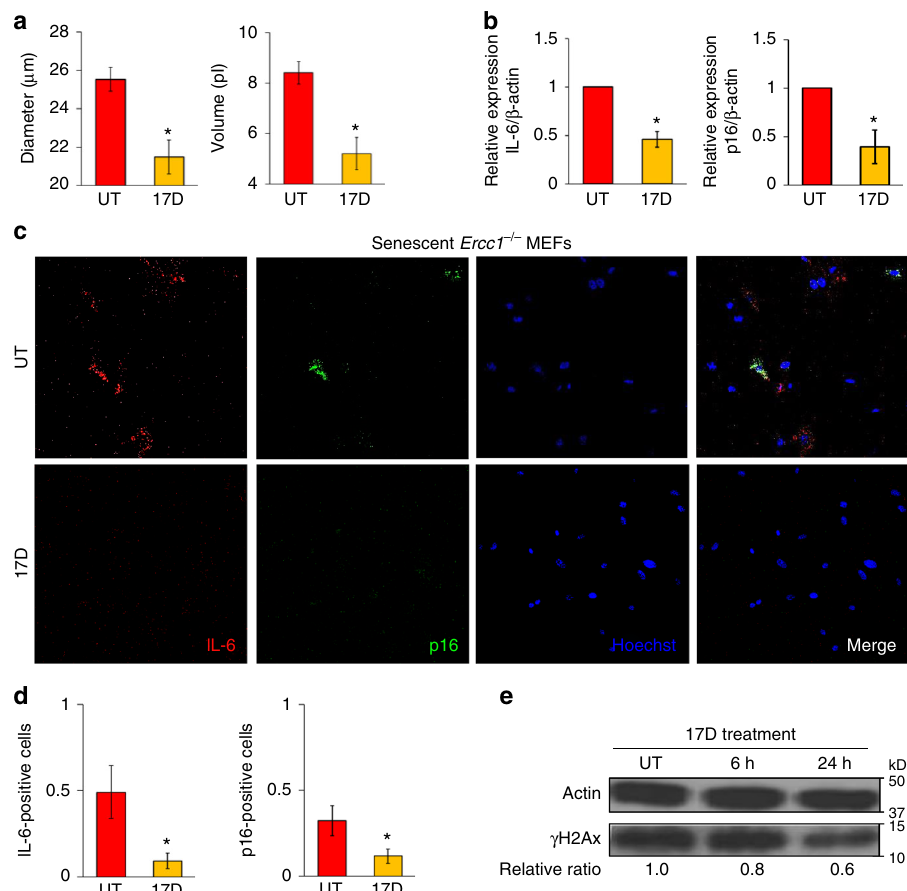
Fig. 7 Multiple senescence markers are reduced in Ercc1 − / − MEFs after treatment with HSP90 inhibitors. a Diameter and volume of senescent Ercc1 − / − MEF cells were measured before ( red ) and after ( orange ) 1 µ M 17-DMAG (17D) treatment for 24 h. Error bars indicate SD for n = 3, * p < 0.05, two-tailed Student ’ s t -test. b Relative mRNA expression of IL-6 and p16 INK4a determined by qRT-PCR was measured in untreated (UT) and 17-DMAG (17D) treated cells for 24 h. Error bars indicate SD for n = 3. * p < 0.05, two-tailed Student ’ s t -test. c Representative FISH images of p16 INK4a ( green ) and IL-6 ( red ) in senescent Ercc1 − / − MEFs with (17D) and without (UT) 17-DMAG treatment. d Quanti fi cation of the fraction of cells expressing p16 INK4a and IL-6 in p5 Ercc1 − / − MEF cells with ( orange ) and without ( red ) 17-DMAG treatment for 24 h determined by ViewRNA FISH. Error bars indicate SD for n = 2. * p < 0.05, two-tailed Student ’ s t -test. e Immunoblot detection of the DNA damage/senescence marker γ H2AX in p5 Ercc1 − / − MEF cultures at several time points following exposure to 100 nM 17-DMAG. Semi-quantitative analysis of γ H2AX expression relative to β -actin. Western blots were quanti fi ed with